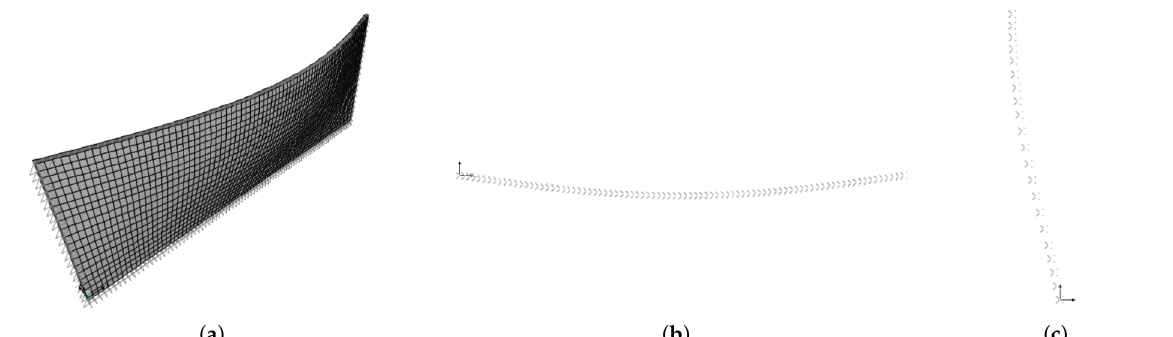
Figure 19. First natural mode of the LTW homogenized model. Natural frequency f = 1.23 Hz. Modal shape in the: ( a ) 3D space; ( b ) x − z plane; ( c ) y − z plane.